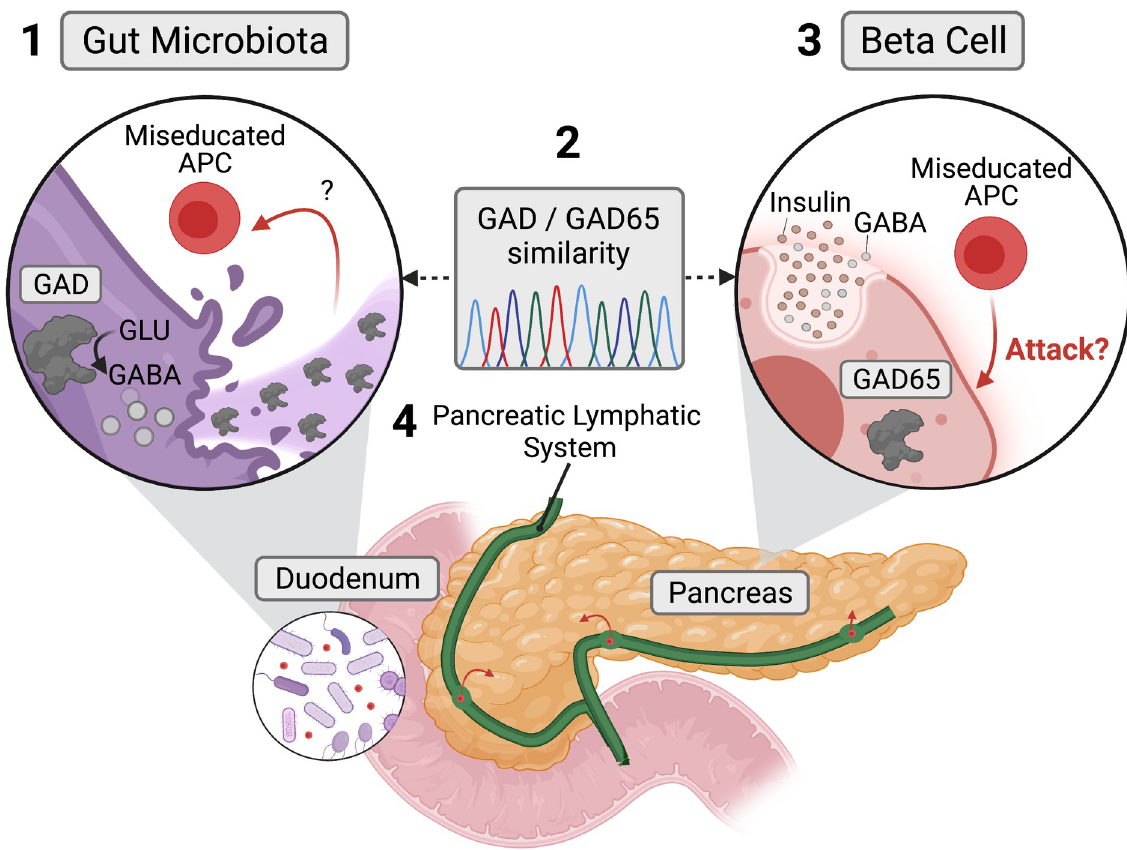
Fig 4. Miseducation of antigen-presenting cells (APCs) by bacterial GAD may contribute to pancreatic beta cell immune-mediated destruction. (1) The death of GABA-producing bacteria at the onset of T1D may release bacterial GAD leading to the miseducation of APCs due to the similarity between bacterial GAD and human GAD65 (2). Therefore, this miseducation could provoke the immune system to attack and produce antibodies targeting human GAD65 expressing beta cells (3). The pancreatic lymphatic system could provide a pathway for these miseducated APCs to traverse from the duodenum into pancreatic islets